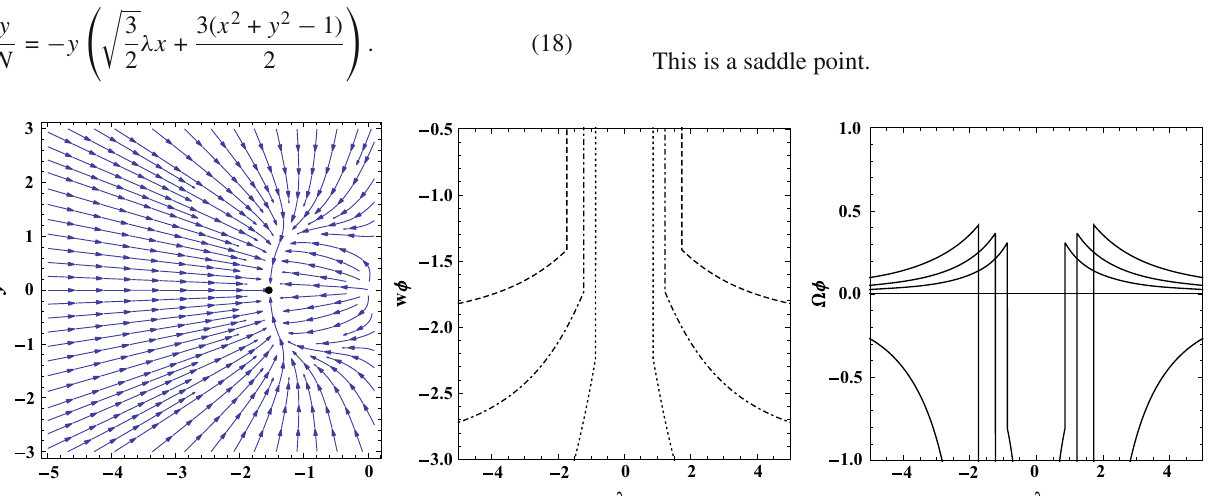
Fig. 4 The left panel shows the phase portrait of Case (4) for Q = β ˙ ρ φ and corresponds to β = − 2 . 5 and λ = 1. The middle and right pan- els show the evolution of w φ and (cid:3) φ versus λ for various values of β . The solid, dashed, dot-dashed and dotted lines correspond to